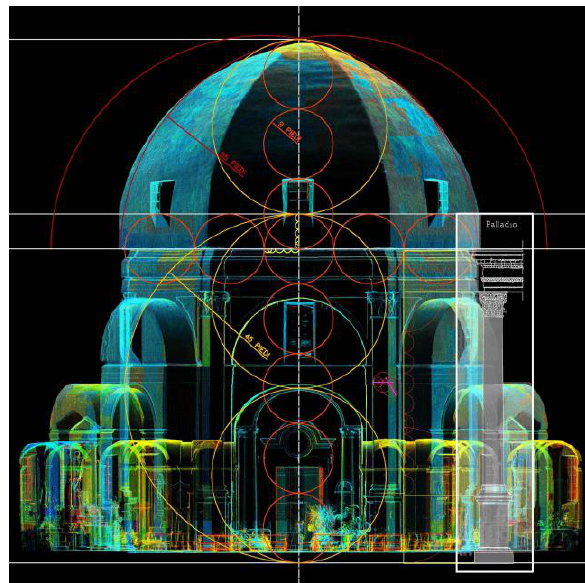
Figure 1. Graphic analysis and metrology study of the Santa Maria del Quartiere church in Parma. (Ghiretti et al.,